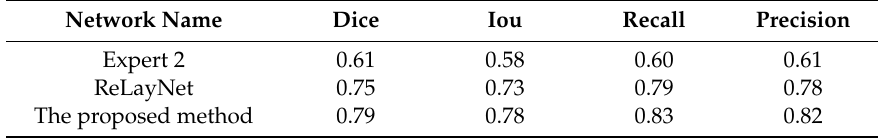
Table 4. Quantitative comparison of segmentation results for diverse edemas in